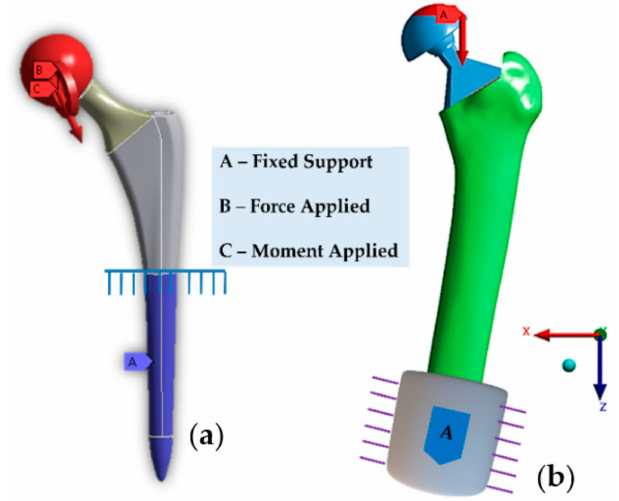
Figure 6. Finite element model view of ( a ) hip implant and a ( b ) hip implant with femur bone with ISO 7206-4 and ISO-7206-8 boundary conditions,